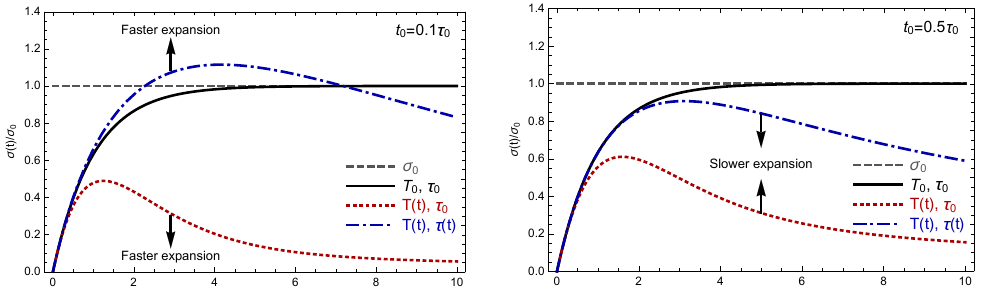
Figure 1. The time-dependent conductivity in plasma without expansion (black solid line) and two models of expanding plasma (red dotted and blue dash-dotted lines). The dashed gray line shows the conventional Ohm’s conductivity of a nonexpanding plasma. The expansion-driven time dependence of the temperature T ( t ) and the transport relation time τ ( t ) is given in Equations (7) and (15),